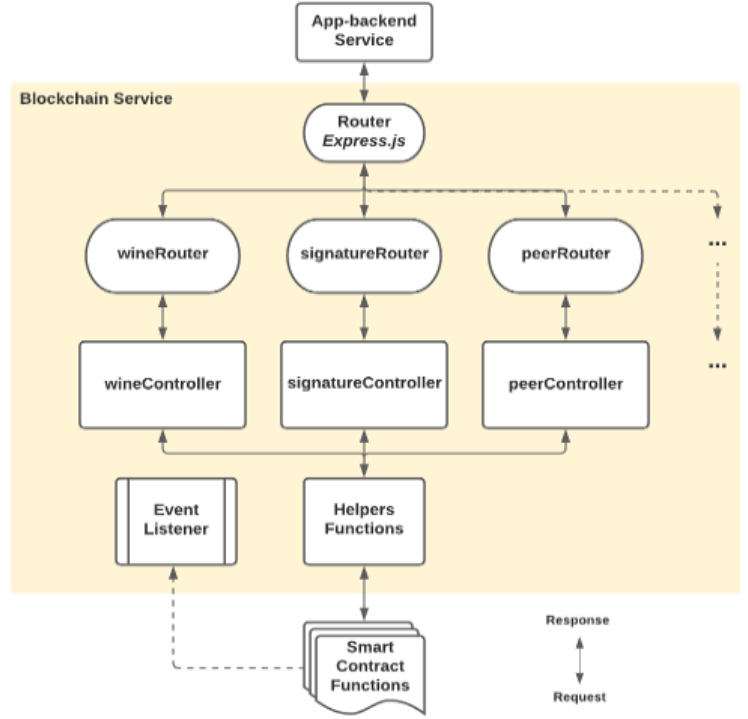
Figure 18. Functional Request Flow of Blockchain